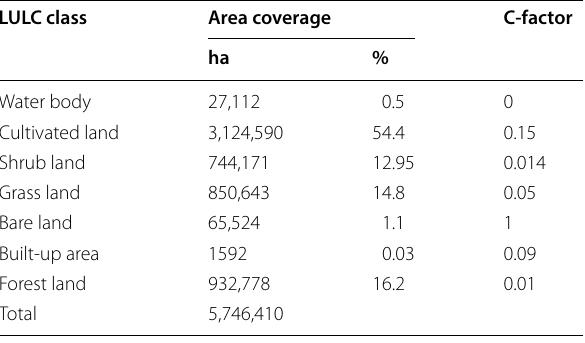
Table 4 Land cover classes and assigned cover (C) factor